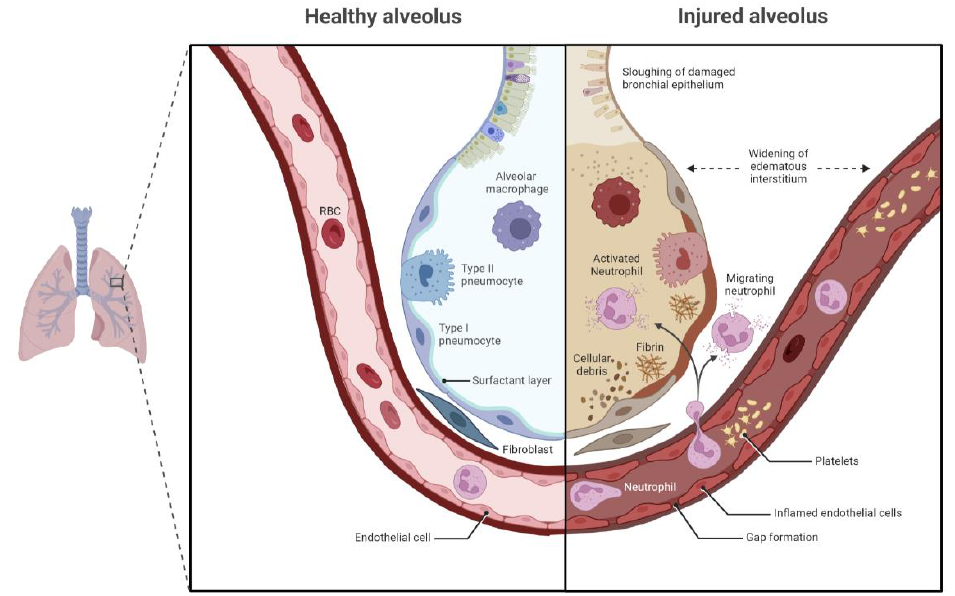
Figure 1. Healthy alveolus and injured alveolus in acute respiratory distress syndrome. Healthy alveolus with resident immune cells on the left , with injured alveolus in ARDS on the right , showing alterations in immune cell populations and endothelial dysfunction. Image created at Biorender.com (accessed on 1 October 2022).